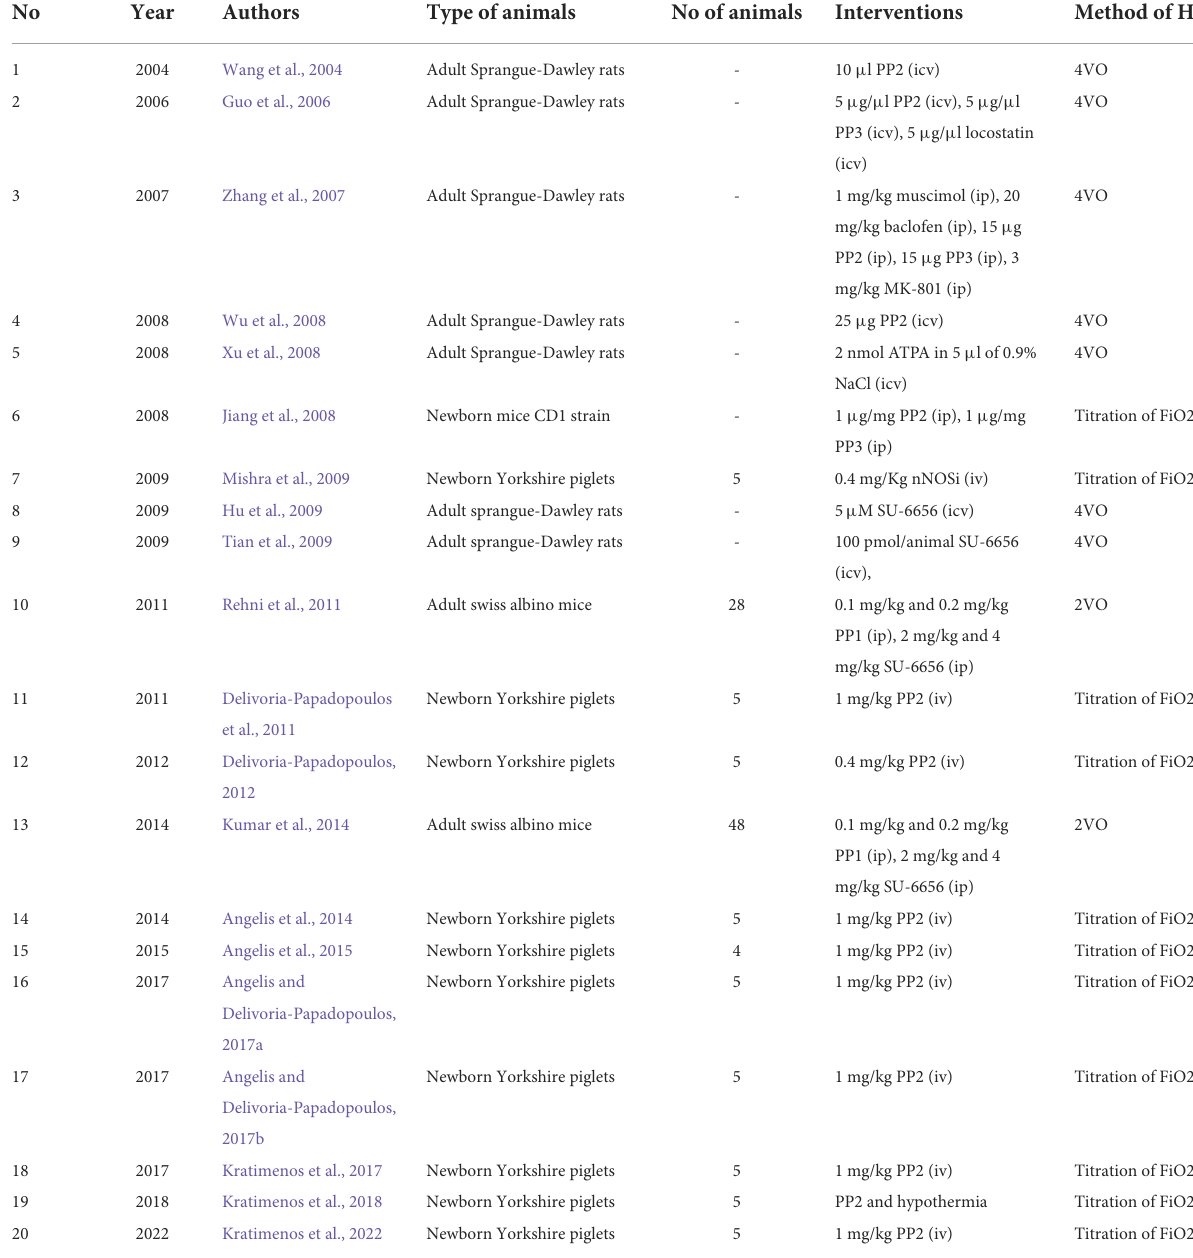
TABLE 3 The included studies and their descriptive